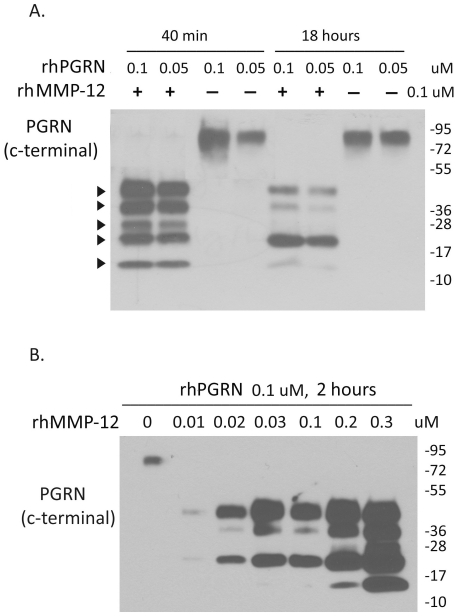
MMP-12 cleaves recombinant PGRN.(A) Varying concentrations of recombinant PGRN (0.05 or 0.1 µM) were incubated with or without activated recombinant MMP-12 (0.1 µM) in a specified assay buffer at 37°C for 40 min or 18 h. Samples were fractionated using a 4–15% gradient gel. (B) MMP-12 dose response: PGRN was incubated with increasing concentrations (0.01–0.3 µM) of MMP-12 for 2 h, then separated using a 4–15% gradient gel. In both samples, five different PGRN cleavage products were noted corresponding to ∼45 kDa, 35 kDa, 25 kDa, 19 kDa and 12 kDa (arrowheads).